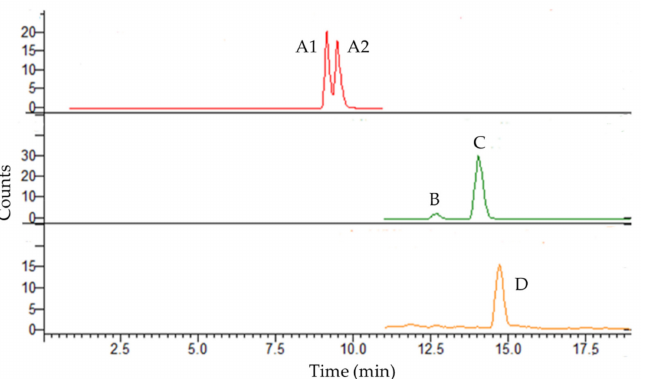
Figure 2. Chromatograms obtained from the LC–MS analysis of aloin B ( A1 ) and aloin A ( A2 ) ( m / z 417.1), aloe emodin ( B ) and emodin ( C ) ( m / z 269.1), and danthron ( D ) ( m / z